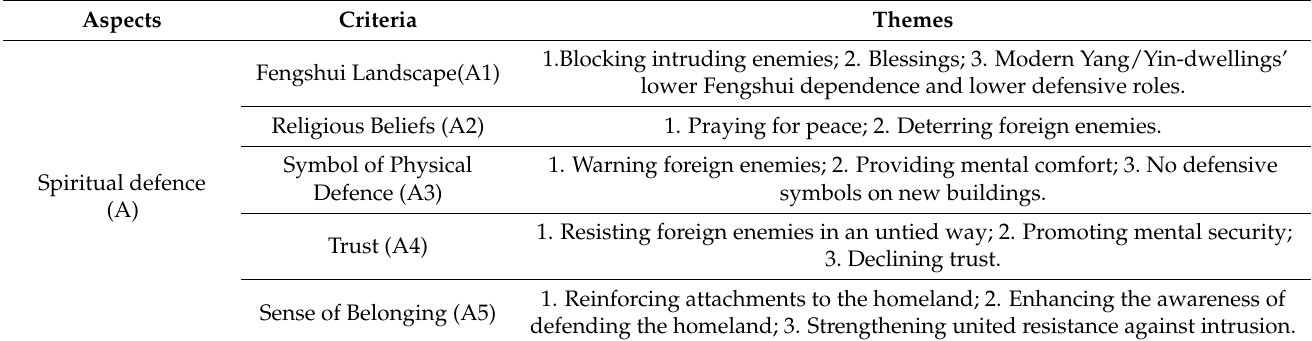
Table 1. Themes concluded in the